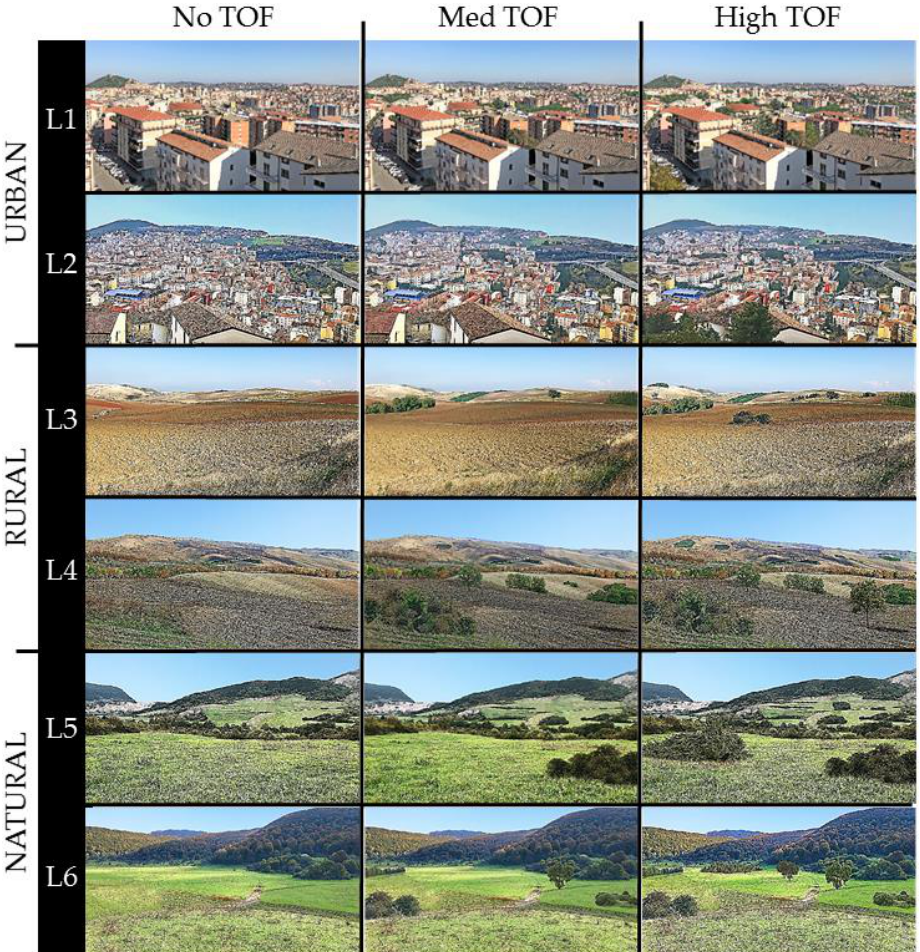
Figure 2. The six triplets of photos edited with a raster graphic editor, showing six different landscape types of the urban – rural – natural gradient (from top to bottom) and three increasing trees outside forests (TOF) covers (from left to right).